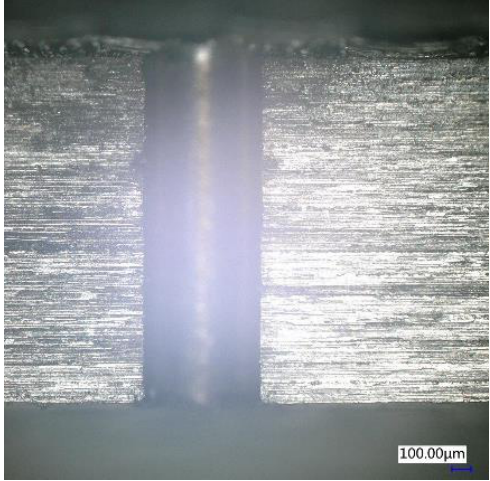
Figure 14. Cross-sectional view of 2 mm drilled hole.